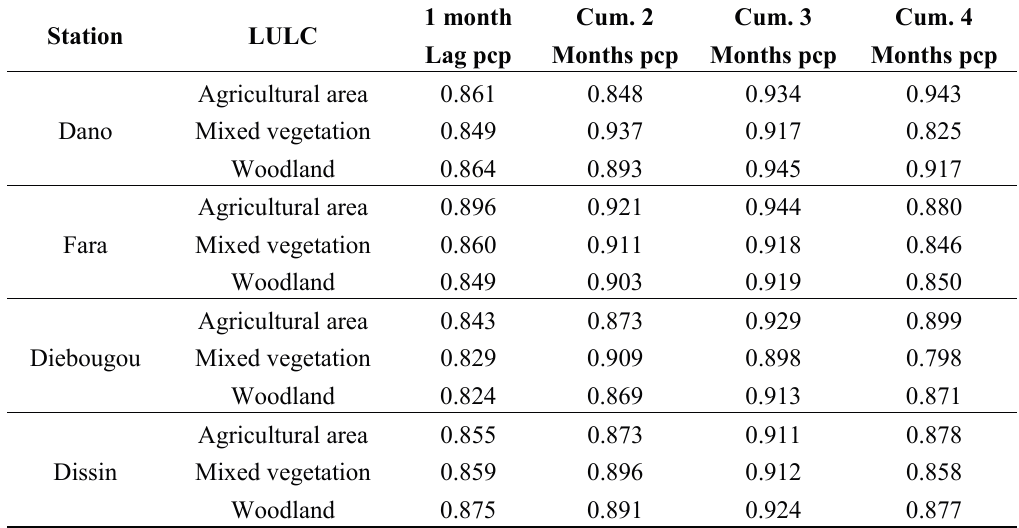
Table 4. Correlation between NDVI of land use/cover types and rainfall variability indicators.